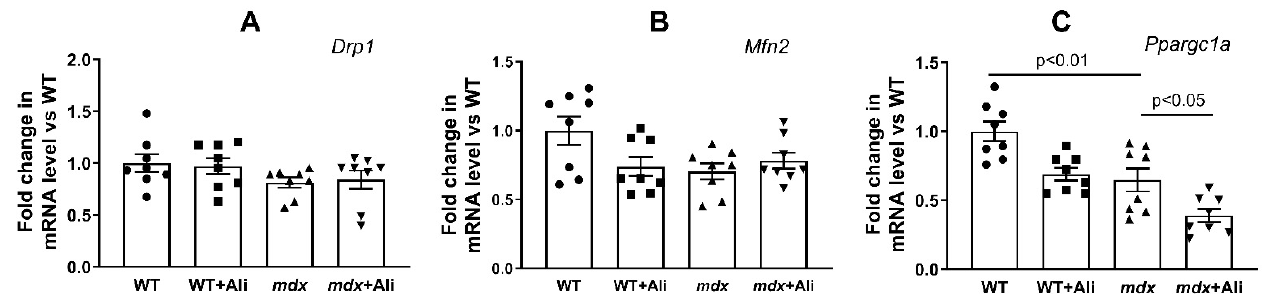
Figure 5. The relative mRNA levels of Drp1 ( A ), Mfn2 ( B ), Ppargc1a ( C ) in the heart of experimental animals. The data are presented as means ± SEM ( n = 8).